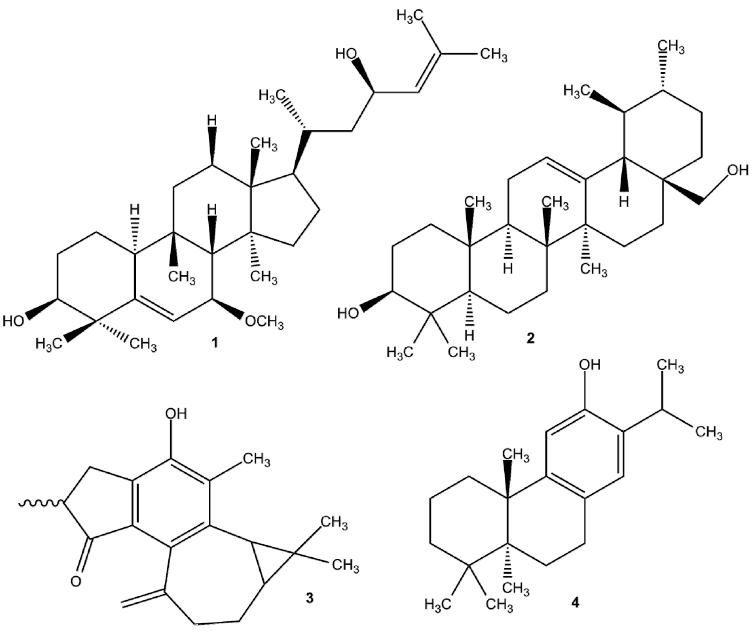
Figure 3. Examples for natural EPI compounds. ( 1 ) Karavilagenin C; ( 2 ) uvaol; ( 3 ) jatropholone A and B; ( 4 ) ferruginol.